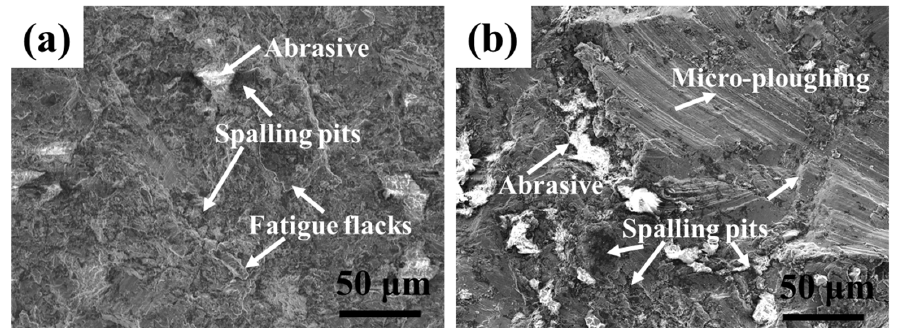
Figure 13. SEM images of the worn surface morphologies after impact wear: ( a ) CIC ‐ 2; ( b ) CIC ‐ 4.